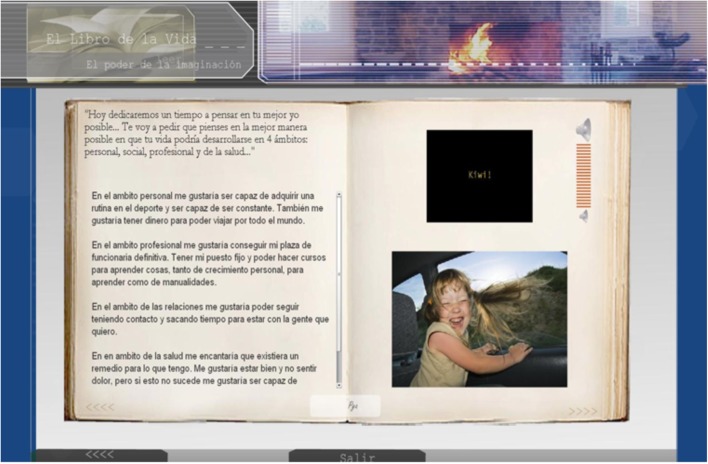
Screenshot of the positive technology application, Book of Life (embedded picture provided by Shutterstock, ID: 60967345).